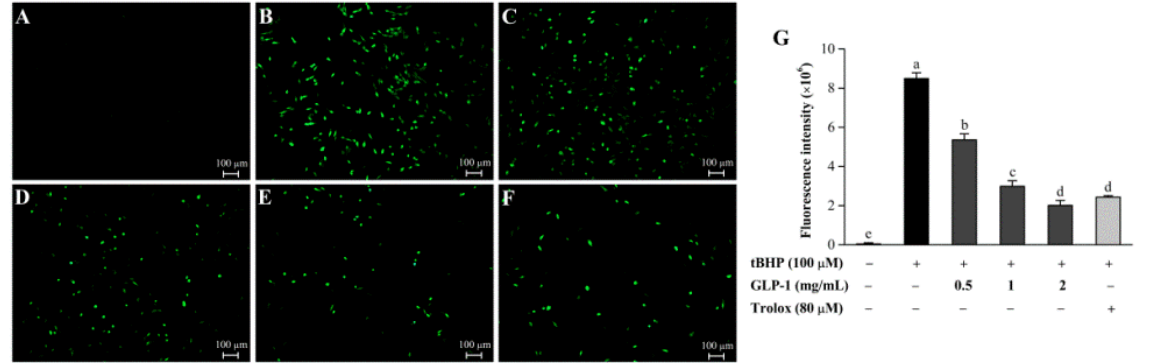
Figure 6. Effect of GLP-1 on intracellular ROS level: blank control group ( A ); cells treated with 100 µ M tBHP ( B ); 100 µ M tBHP + 0.5 mg/mL GLP-1 ( C ); 100 µ M tBHP + 1 mg/mL GLP-1 ( D ); 100 µ M tBHP + 2 mg/mL GLP-1 ( E ); 100 µ M tBHP + 80 µ M Trolox ( F ). Fluorescence intensity analysis ( G ). Data are presented as mean ± S.D. Values with different letters (a–d) denote the significant differences ( p <